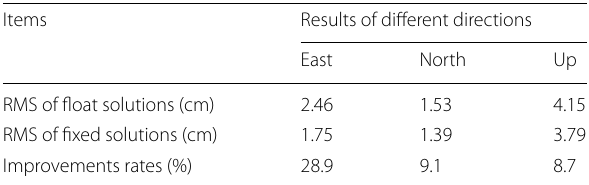
Table 2 Average position errors RMS of Kinematic PPP at